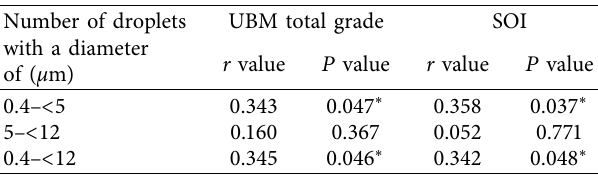
Table 1: Correlations between number of SO droplets in the frst or last washout and UBM total grade or